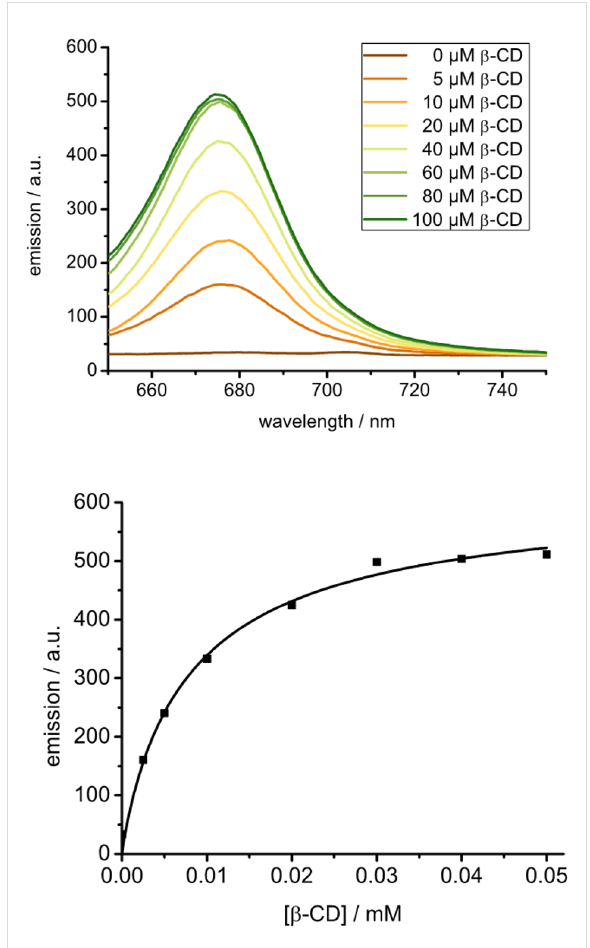
Figure 3: Top: Emission spectra (ex: 630 nm) of AdSq immobilized at CDV. [CDV] = 0–100 µM; [AdSq] = 5 µM. Bottom: Langmuir regres- sion of a fluorescence titration of CDV to AdSq. [AdSq] = 10 µM, [CDV] = 0–100 µM. It is assumed that only cyclodextrins on the outer surface of the CDV are available for host–guest